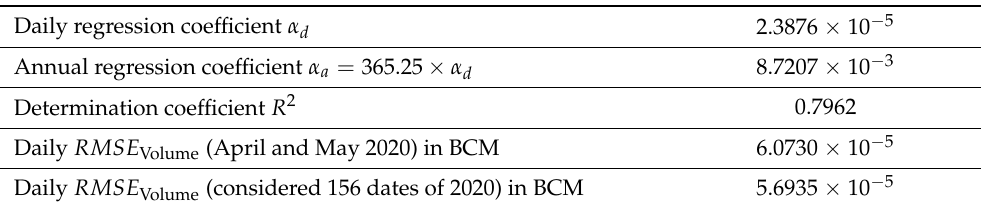
Table 3. Obtained results by means of the established intercepting zero “first-order” polynomial regression model using the two months of April and May 2020.